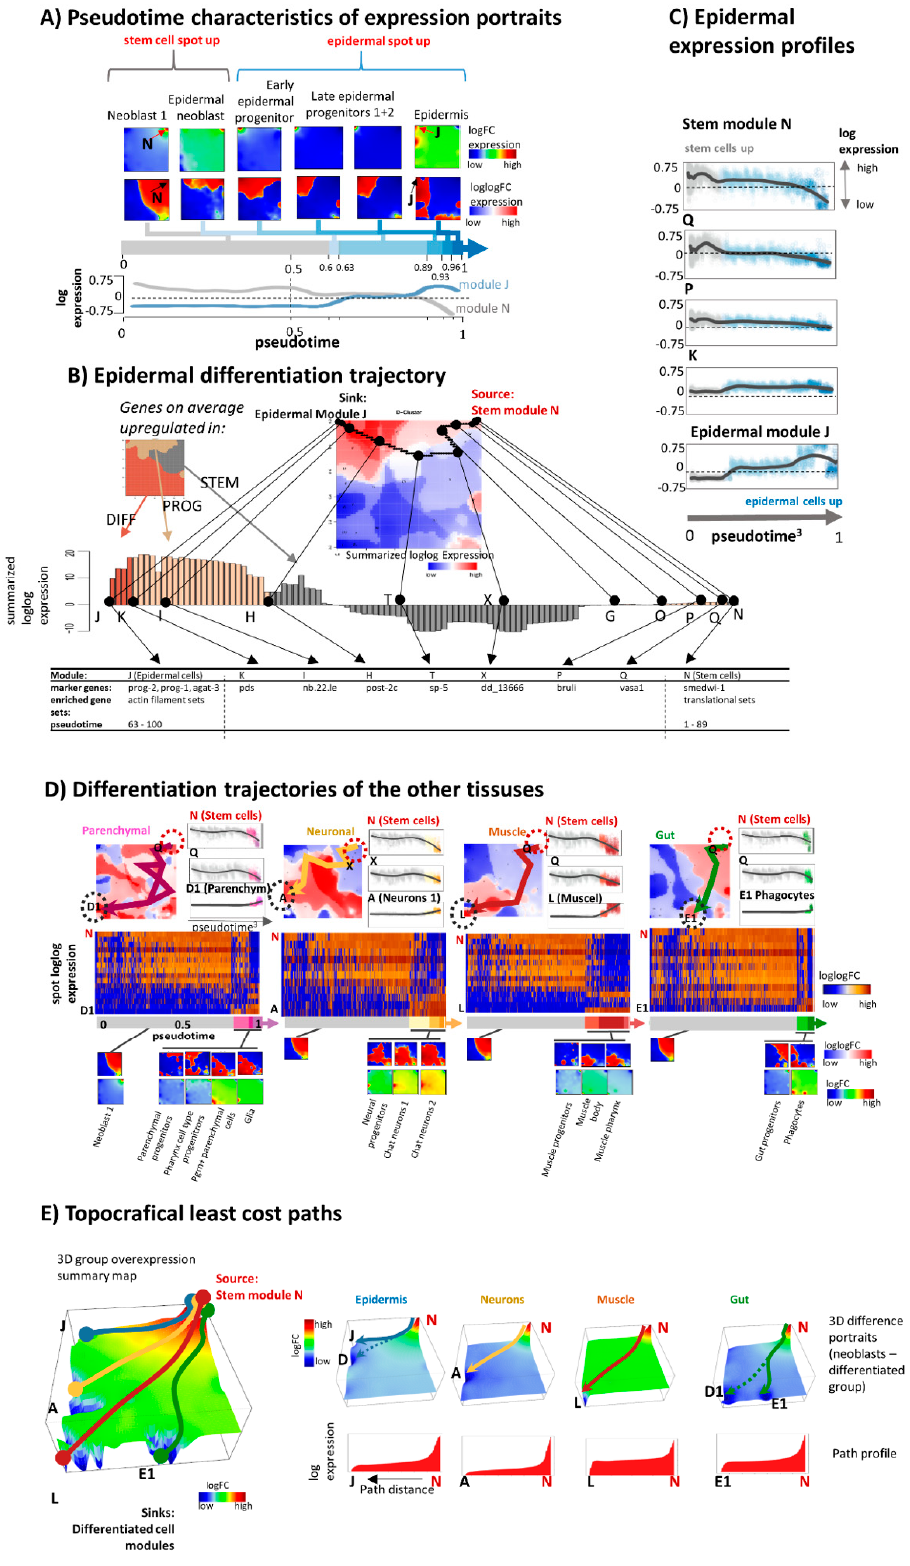
Figure 4. Gene expression trajectories of planarian tissue development. ( A ) Expression portraits (in log FC and loglog FC scales) of the epidermal lineage illustrate the change of module-patterns during differentiation. The “loglogFC” scale better resolves subtle changes between over- and under-